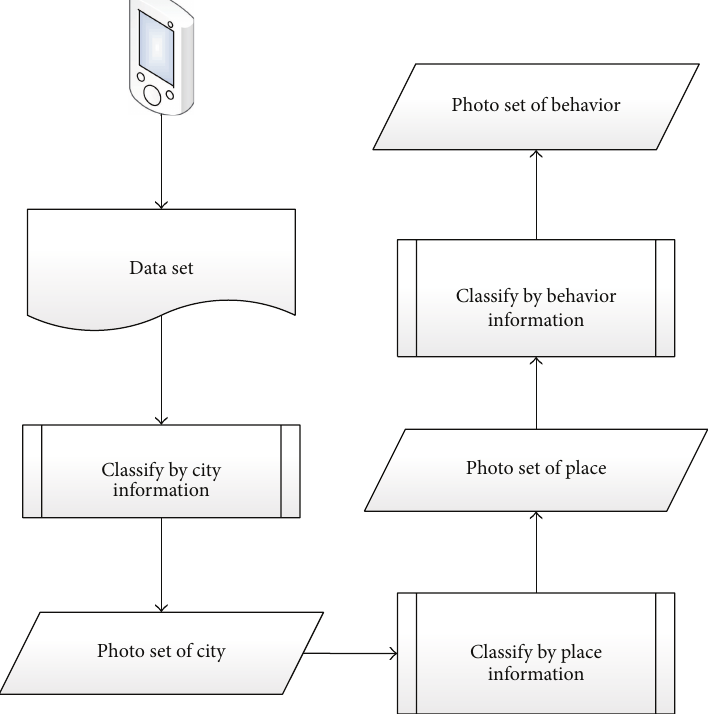
Figure 1: Classification flow chart.